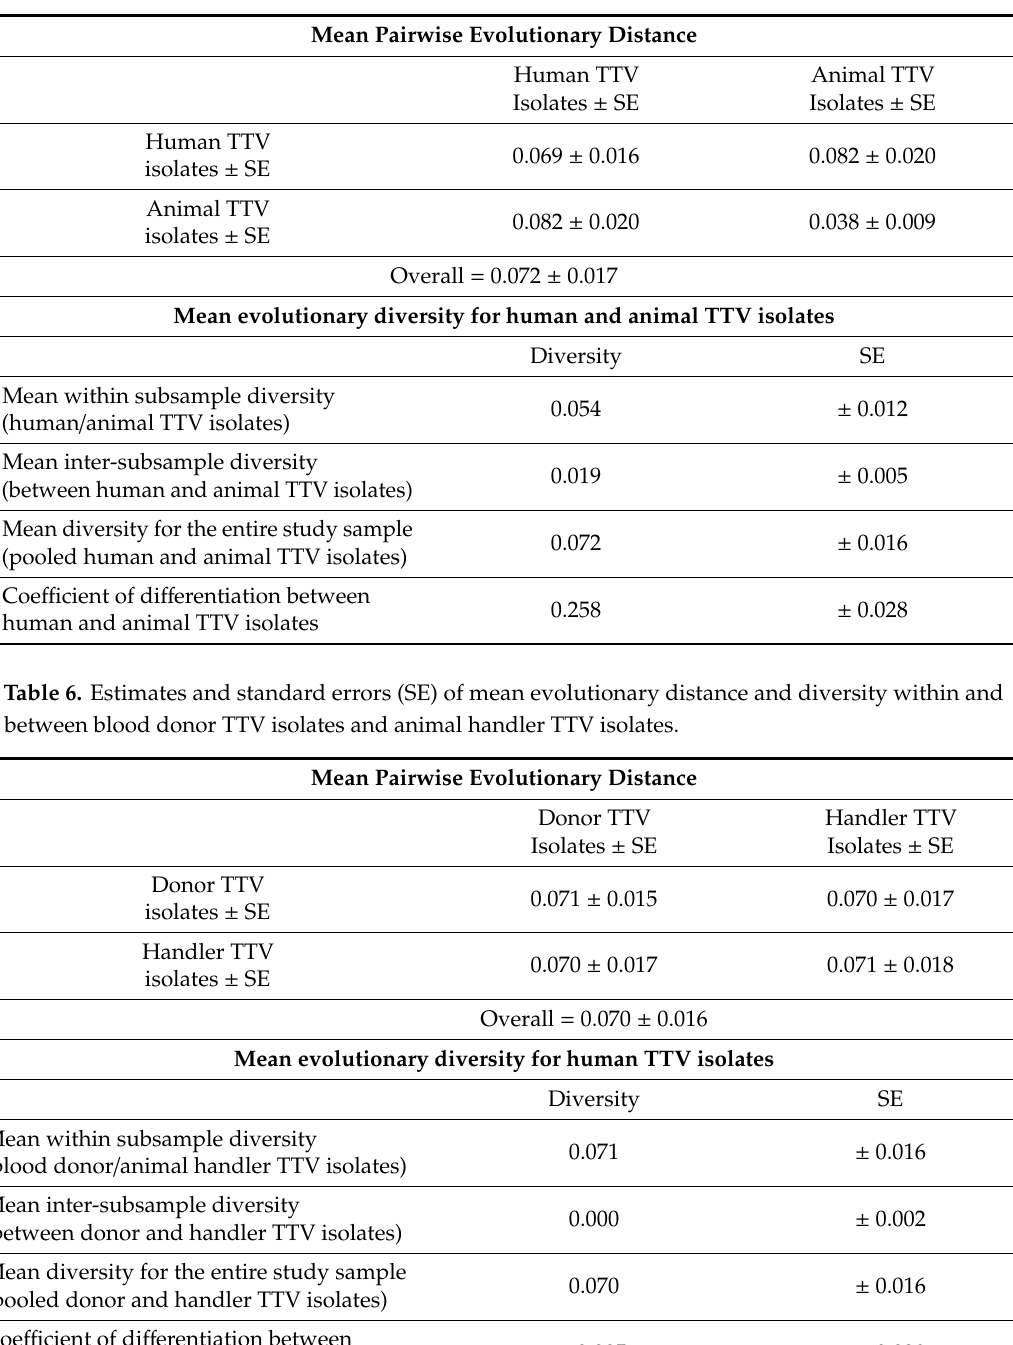
Table 5. Estimates and standard errors (SE) of mean evolutionary distance and diversity within and between human TTV isolates and domestic farm animal (all species) TTV isolates.